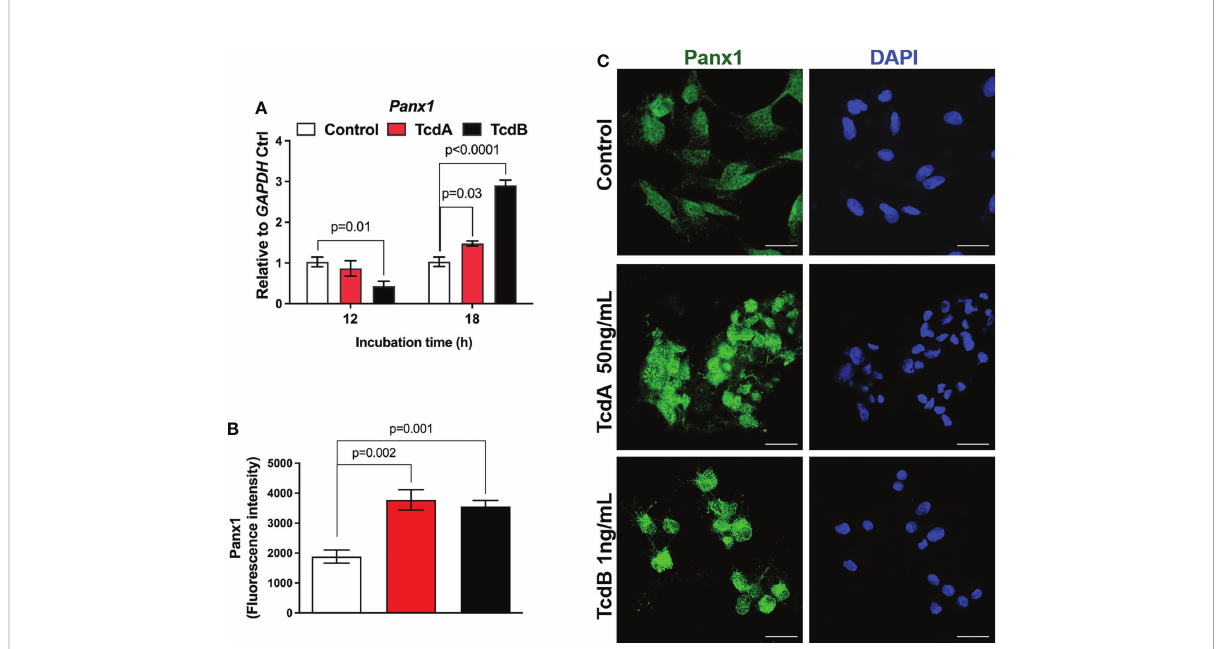
FIGURE 2 TcdA and TcdB alter Panx1 gene expression in EGCs in vitro . (A) Gene expression of Panx1 were evaluated by qPCR in EGC incubated with DMEM only (control), TcdA (50 ng/mL) and TcdB (1 ng/mL). The data are the mean ± SEM. p value is represented in the graph; the one-way ANOVA test followed by the Tukey test was used. (B) Fluorescence intensity of Panx1 immunostaining in EGCs measured by ImageJ software. The data are the mean ± SEM. One-way ANOVA followed by the Tukey test was used. p value is represented in the graph. (C) Representative photomicrographs of Panx1 (green) immunostaining and DAPI (blue) nuclear staining in EGCs exposed to TcdA and TcdB after 18 h of